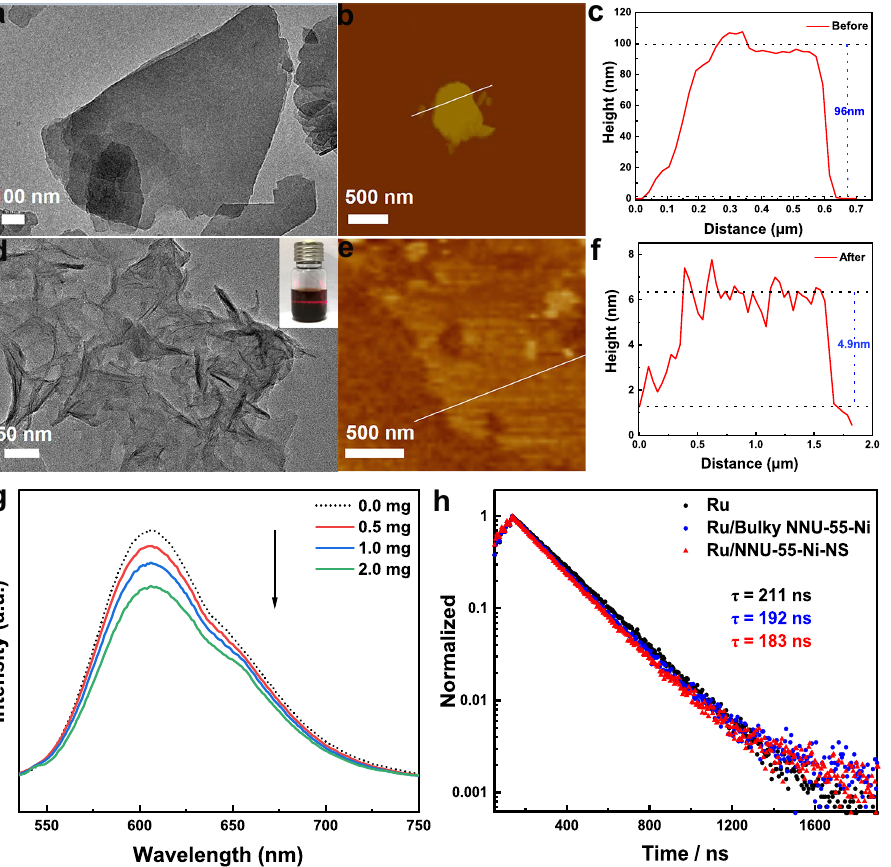
Fig. 4 Characterization and optical properties of NNU-55-Ni-NS. a – c TEM and AFM images of the bulky NNU-55-Ni. The height pro fi le along the white line represents the thickness of the bulky NNU-55-Ni. d – f After the bulky NNU-55-Ni was in situ exfoliated into NNU-55-Ni-NS, leading to a change in TEM, AFM, and height pro fi le. g The steady-state fl uorescent spectra of [Ru(bpy) 3 ]Cl 2 upon the addition of increasing amounts of NNU-55-Ni-NS. h Time ‐ resolved fl uorescence decay spectra of [Ru(bpy) 3 ]Cl 2 in the presence of different